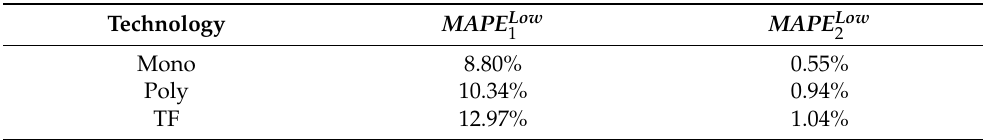
Table 8. MAPE for monocrystalline, polycrystalline, and thin-films modules, under Low-Irradiance Conditions (Low). MAPE Low